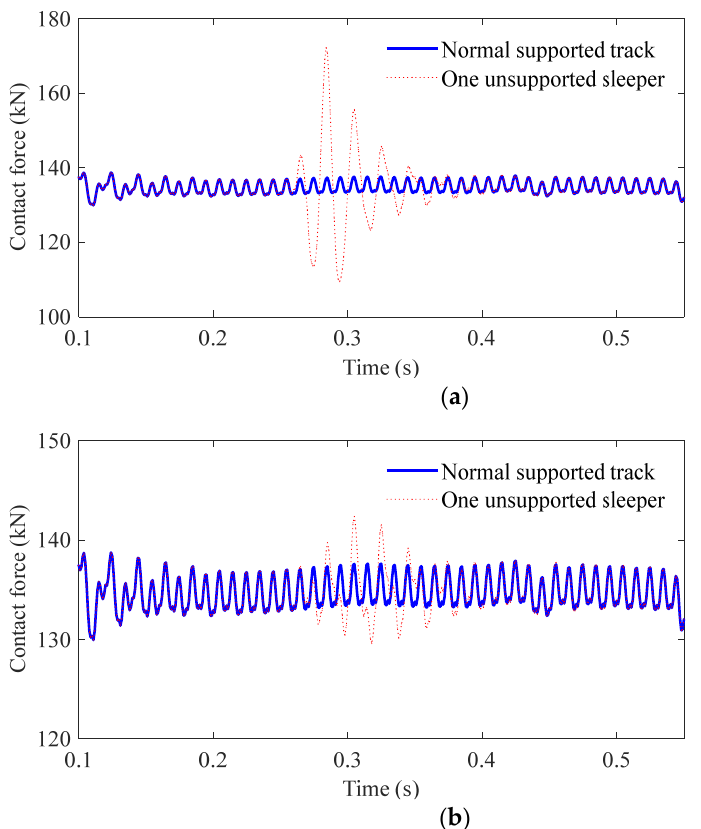
Figure 13. Wheel–rail vertical contact forces under the unilateral unsupported sleepers at point B: ( a ) left side and ( b ) right side.